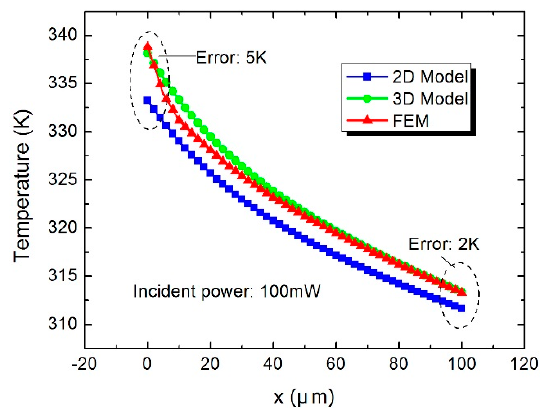
Figure 6. Temperature distribution in the BB ′ (y = 279 μ m) direction.